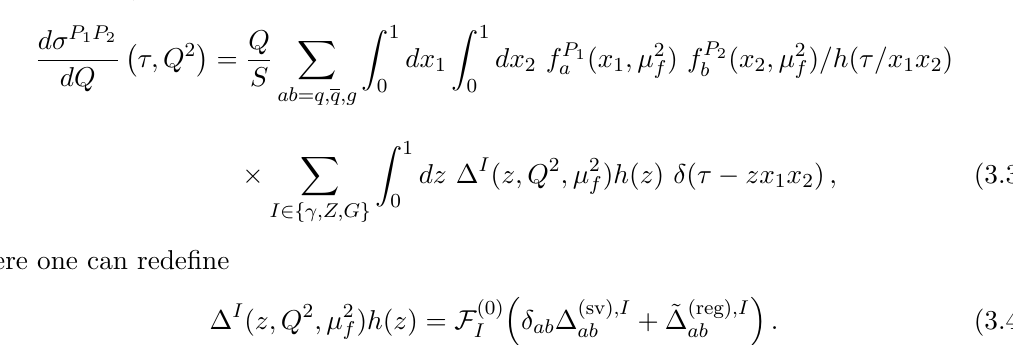
Figure 7 . The ratio of modi(cid:12)ed SV coe(cid:14)cient (SVM) for the choices h ( z ) = 1 ; z; z 2 ; z (cid:0) 1 and total correction in gg channel at O ( (cid:11) s ) (left) and O ( (cid:11) 2 ) (right) for gravity only. s approximation, we multiply a simple polynomial h ( z ) with the partonic SV coe(cid:14)cient. The function h ( z ) is such that it becomes unity in the limit z ! 1. The eq. (2.1) then takes the